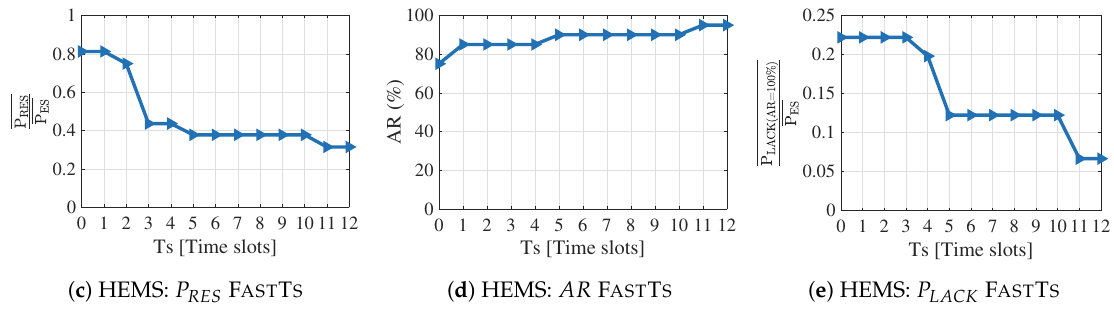
Figure 12. Performance evaluation of F AST T S in the HEMS scenario. Parameters: N = 20 and numPart = 2, the rest of parameters according to Case F in Table